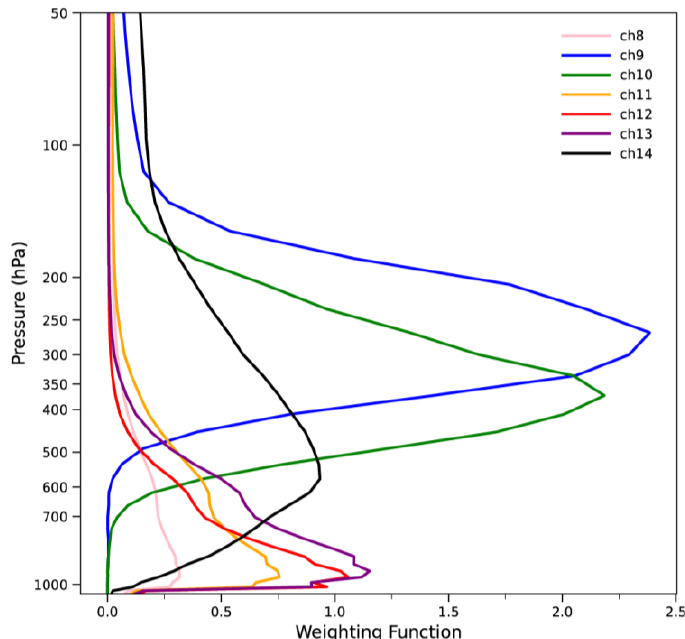
Figure 1. The distributions of weighting function of AGRI infrared channels 8 – 14 calculated using the background atmospheric profiles as the input for the RTTOV radiative transfer model.